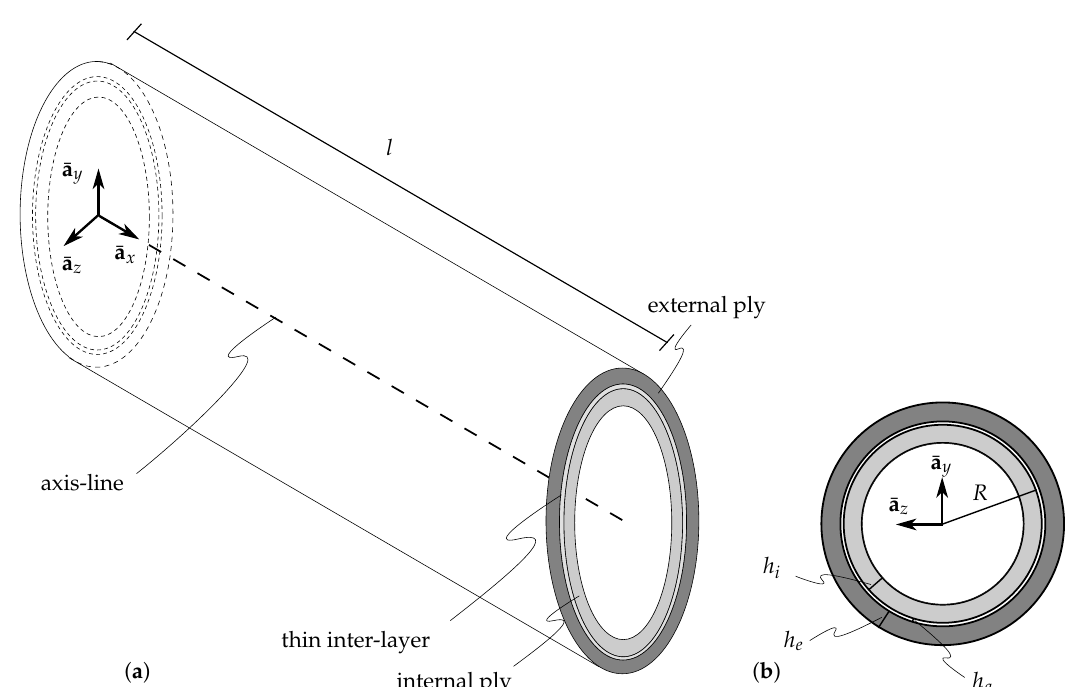
Figure 1. The double-layered beam with an annular cross-section: ( a ) complete view; ( b ) details of the cross-section.